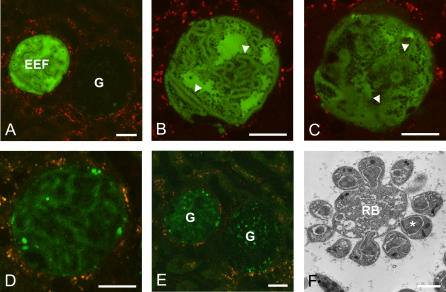
Rapid EEF Decay(A–D) Individual frames from an intravital video showing the process of liver stage transformation into an EEF ghost (see Video S5). (A) The still image shows an intact EEF adjacent to a ghost. G, ghost.(B) Individual frame showing rapid decay of the EEF shown on the left of (A). Note that loss of cytosolic GFP reveals the presence and arrangement of the merozoites (arrow).(C–D) Only a few of the thousands of merozoites remain visible in the faintly fluorescent EEF ghost.(E) Eventually, the infected hepatocyte has transformed into an EEF ghost. Note that both ghosts retain close contact with the surrounding tissue (A–E). Bars = 20 μm.(F) Electron micrograph showing a liver sinusoid with merozoites that are incompletely separated from a remnant body. RB, remnant body; G, ghost; *, merozoite. Bar = 1 μm.